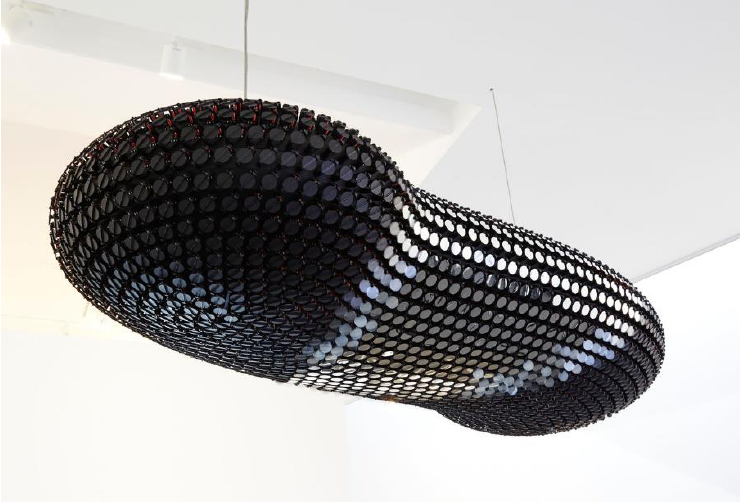
Figure 2. Kinetic sculpture "The Cloud" by Troika at Terminal 5 o Heathrow Airport,